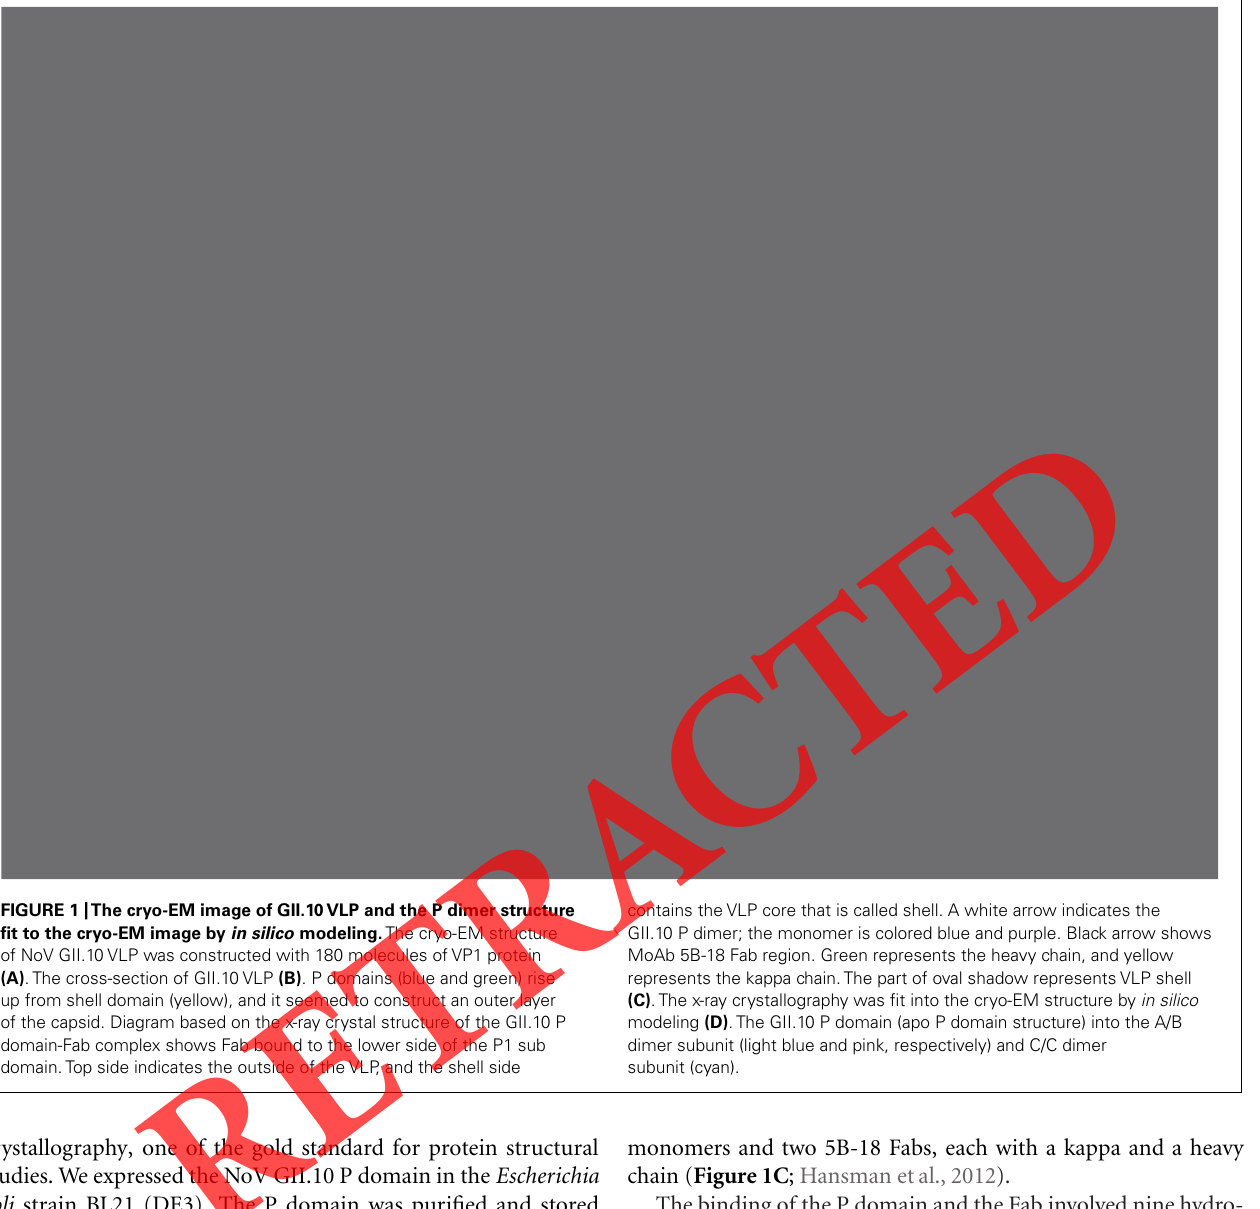
contains theVLP core that is called shell. A white arrow indicates the GII.10 P dimer; the monomer is colored blue and purple. Black arrow shows MoAb 5B-18 Fab region. Green represents the heavy chain, and yellow represents the kappa chain.The part of oval shadow representsVLP shell (C) .The x-ray crystallography was fit into the cryo-EM structure by in silico modeling (D) .The GII.10 P domain (apo P domain structure) into the A/B dimer subunit (light blue and pink, respectively) and C/C dimer subunit